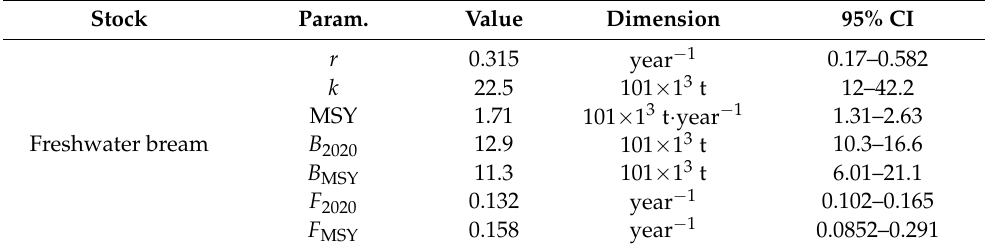
Figure 4. Viable r – k pairs ( r —the maximum intrinsic rate of population increase; k —carrying capacity, i.e., a parameter of the Schaefer model indicating unexploited stock size). Table 5. The results of CMSY analysis are based on viable r – k pairs and results for management based on CMSY